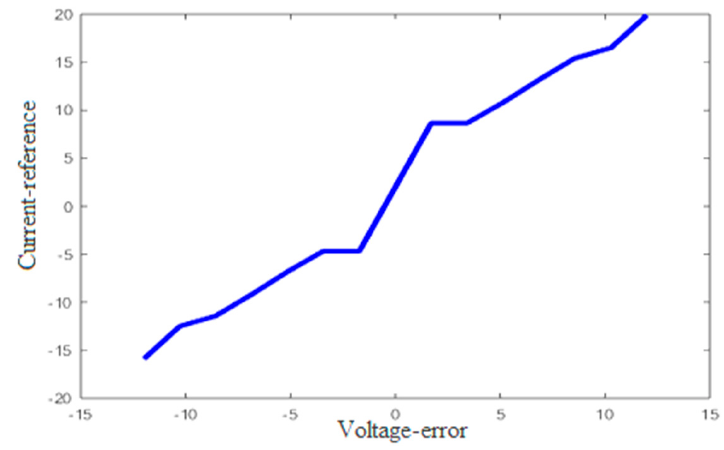
Figure 20. Fuzzy surface viewer.